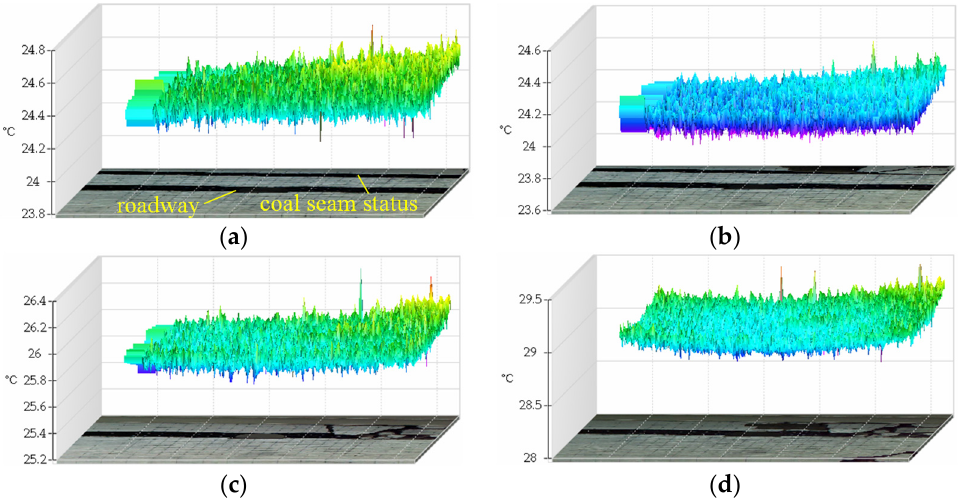
Figure 11. Three ‐ dimensional temperature field of surrounding rock in mining roadway in different coal seams. ( a ) No ‐ mining; ( b ) 16# coal mining; ( c ) 17# coal mining; and ( d ) 18# coal mining.